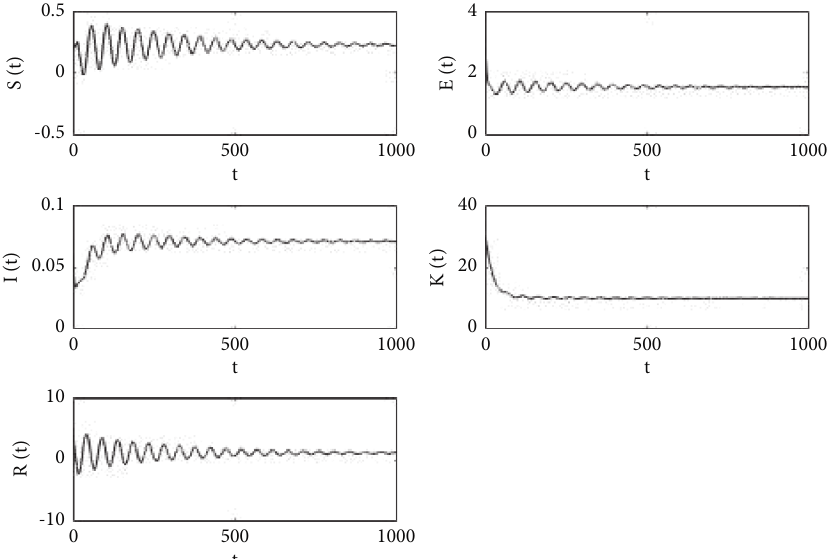
Figure 1: State trajectories of fractional system (4). When τ ymptotically stable.